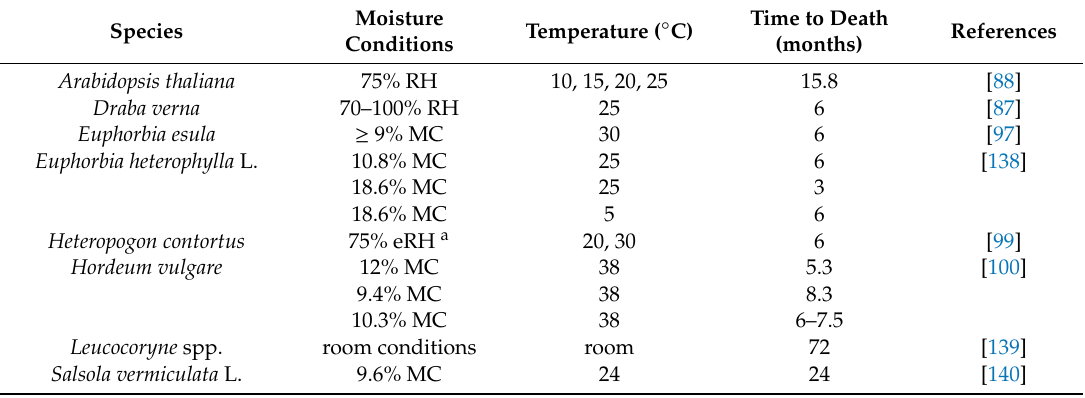
Table 2. Storage conditions that promoted afterripening, but a prolonged period at these conditions resulted in seed death. Authorities are given only for species not mentioned in the